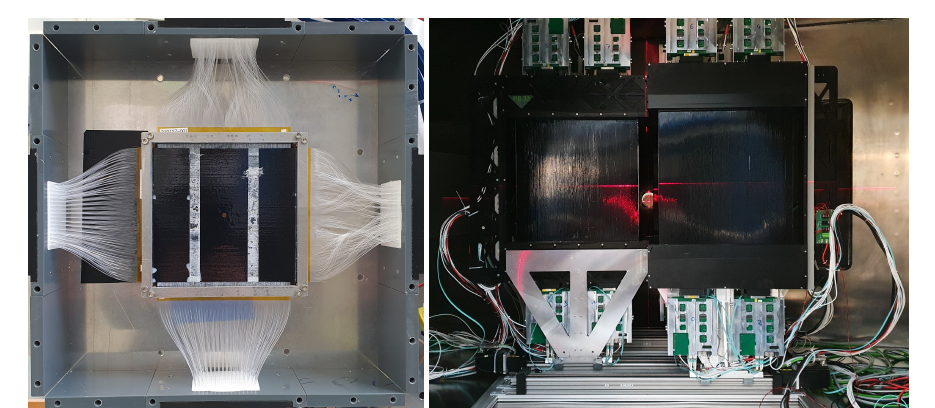
Figure 2. Fiber scintillator detectors for fragment tracking. Left: Two fiber detectors with 250 µ m fibers, 10x10 cm 2 active area, and a 3 mm diameter hole, mounted in front of the magnet. Right: Four fiber detectors with 1000 µ m fibers 50x50 cm 2 active area mounted inside the vacuum chamber behind GLAD. All detectors are mounted on drives to adjust the hole or gap.